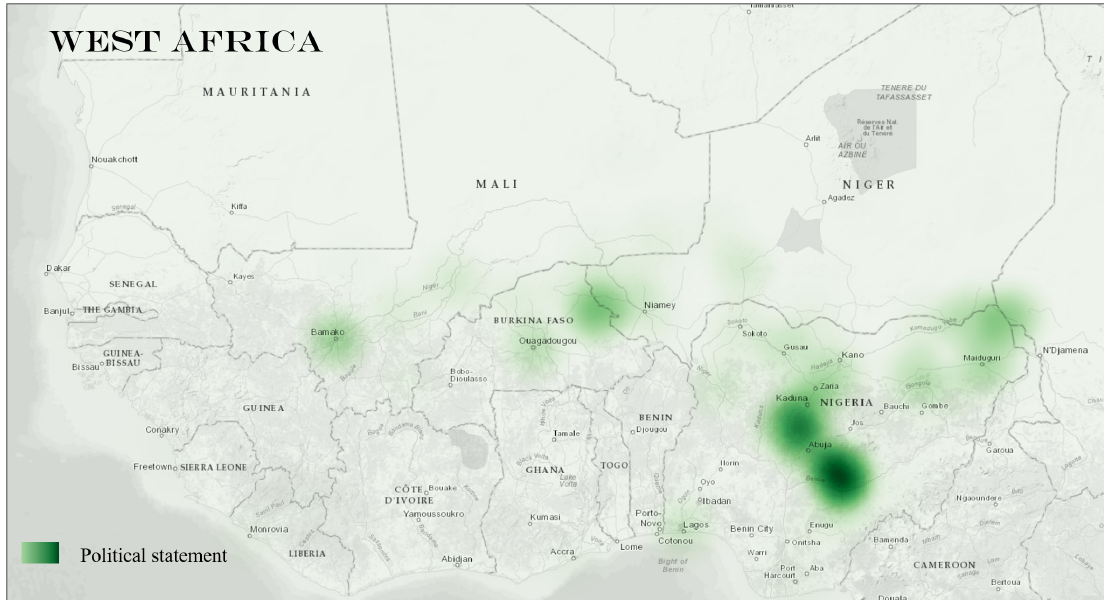
Figure 5. The hotspots of locations mentioned in articles that are mostly concerned with the theme of Political statement